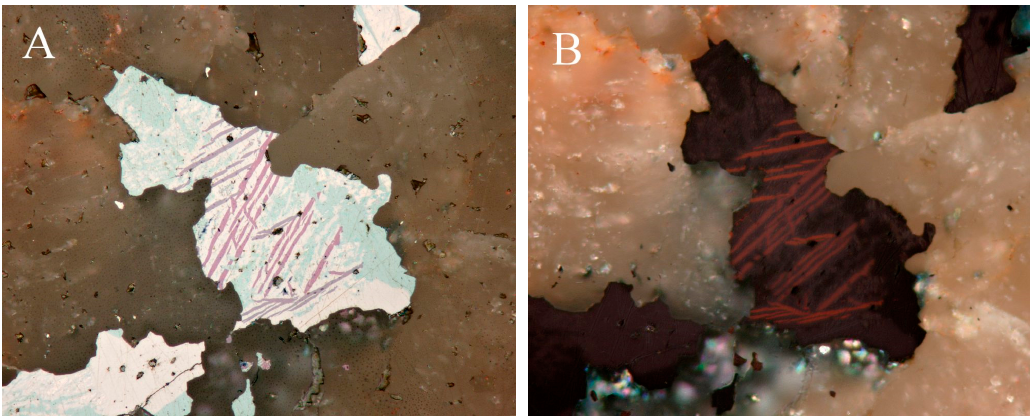
Figure 74. Lamellae of violet umangite replace bluish berzelianite. White eucairite is in the association. Reflected light, ( A ) one polarizer; ( B ) crossed polarizers. FOV 210 μ m. P ř íbram, a dump of the shaft 16. Photo by P.